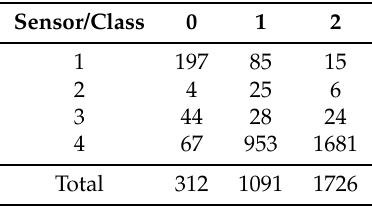
Table 3. Number of instances per dataset.